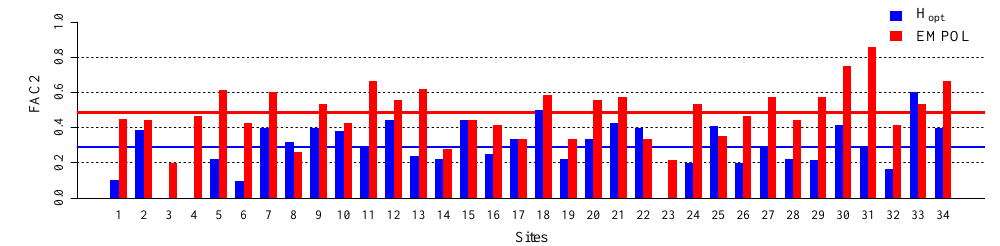
Fig. 7. Fractions of predictions within a factor of two of observations for the two model configurations at each of the measuring sites. The colored lines denote the mean over all stations.